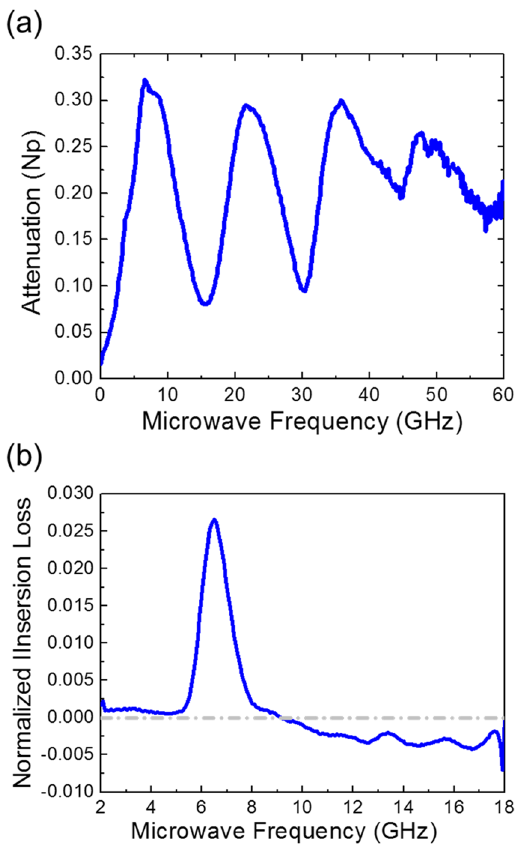
Figure 3. Microwave resonant absorption spectra of WSSV after removing the contributions from the background. ( a ) First set of measurement with a 65 GHz measurement bandwidth. ( b ) Second set of measurement with a 18 GHz measurement